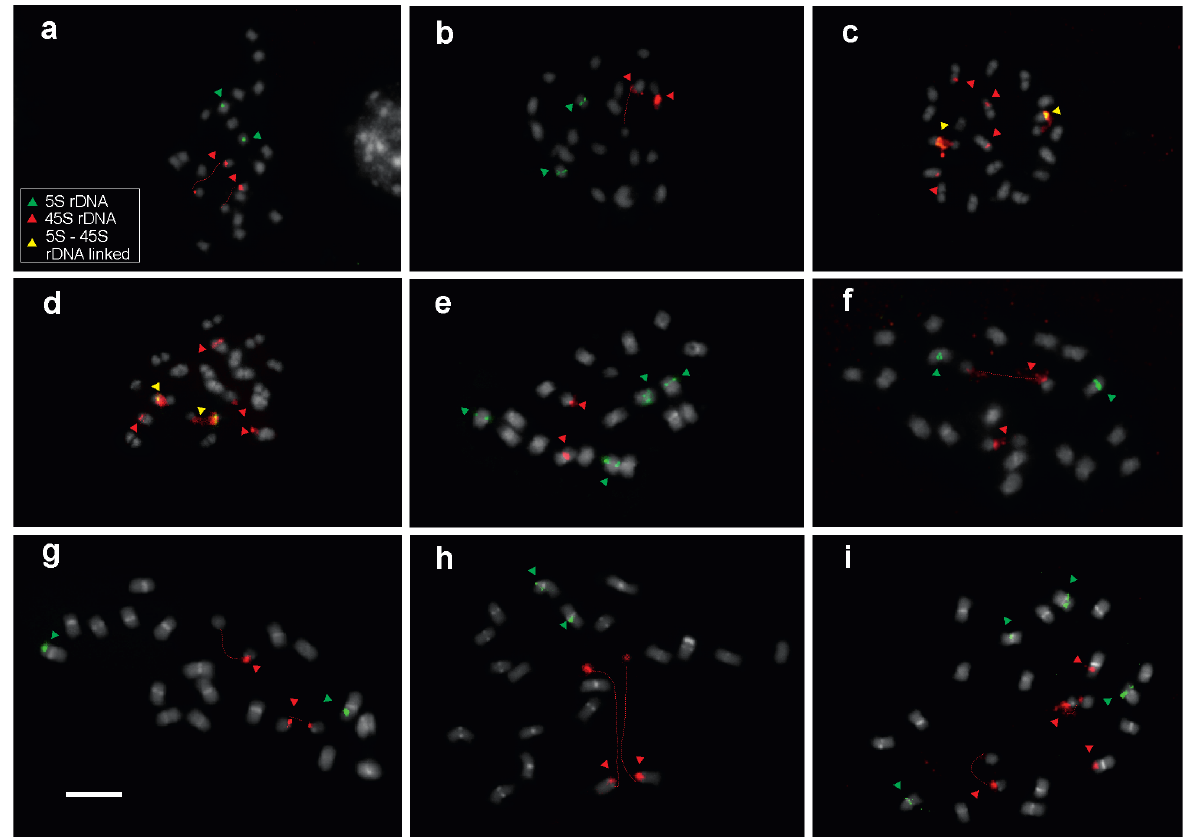
Figure 1. Somatic metaphases of Arachis species belonging to different sections after double fluorescent in situ hybridization (FISH) with ribosomal markers. The 5S rDNA loci are illustrated by the green signals and the 18S–26S rDNA loci by the red signals. DAPI counterstaining in gray is highlighting the heterochromatin bands. The arrows illustrate the homologous position of rDNA signals. a- A. triseminata (Triseminatae); b- A. dardani (Heteranthae); c- A. pusilla VFaPzSv 13107 (Heteranthae); d- A. pusilla V13189 (Heteranthae); e- A. pintoi (Caulorrhizae); f- A. repens (Caulorrhizae); g- A . benthamii (Erectoides); h- A. matiensis (Procumbentes); i- A. vallsii (Procumbentes). Scale bar 5